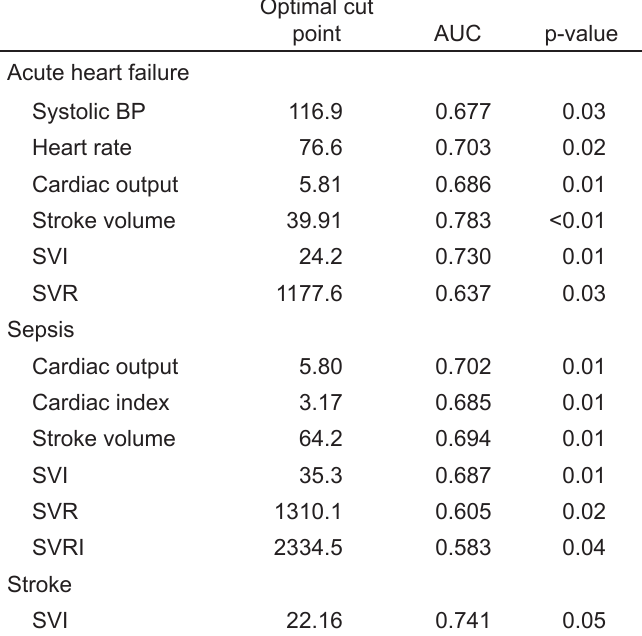
Table 4. Significant hemodynamic predictors for 30-day